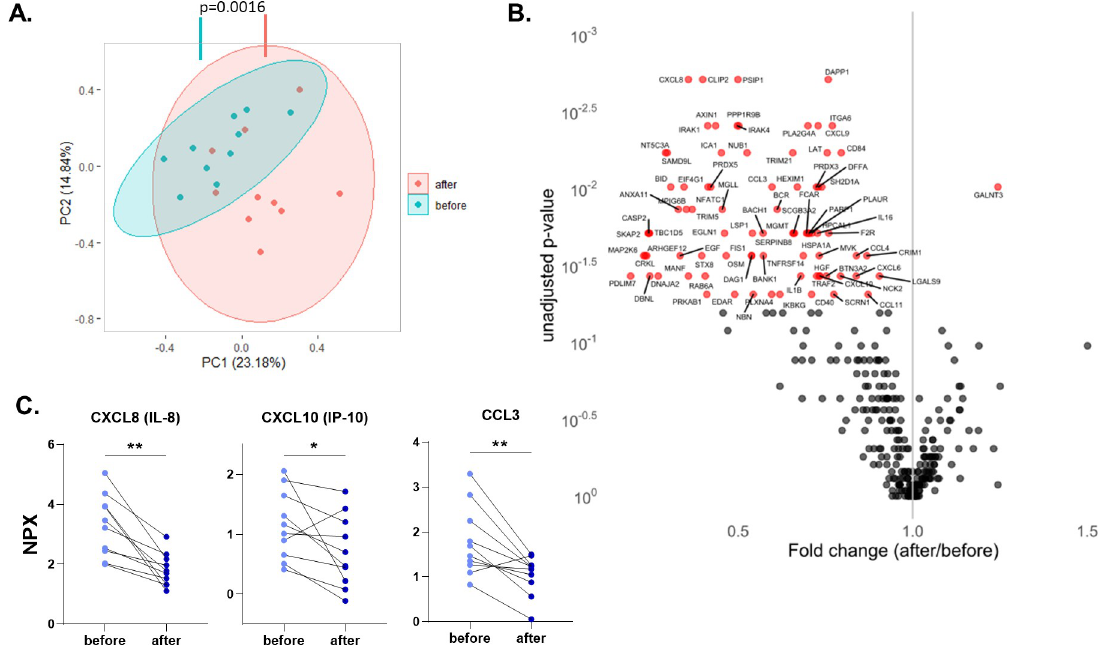
Fig 3. Influenza vaccination downregulates circulating inflammatory proteins. A. Principal component analysis (PCA) of circulating proteins belonging to 10 participants before and after vaccination. The mean difference between before and after in PC1 was calculated by Wilcoxon signed-rank test. B. Volcano plot depicting the fold changes after influenza vaccination. Red dots show significantly changing proteins. C. Selected chemokines whose abundances significantly decrease after the vaccination. Differences between protein expressions before and after influenza vaccination were analyzed using the Wilcoxon signed-rank test, n = 10. NPX: Normalized protein expression. � p < 0.05, �� p < 0.01.